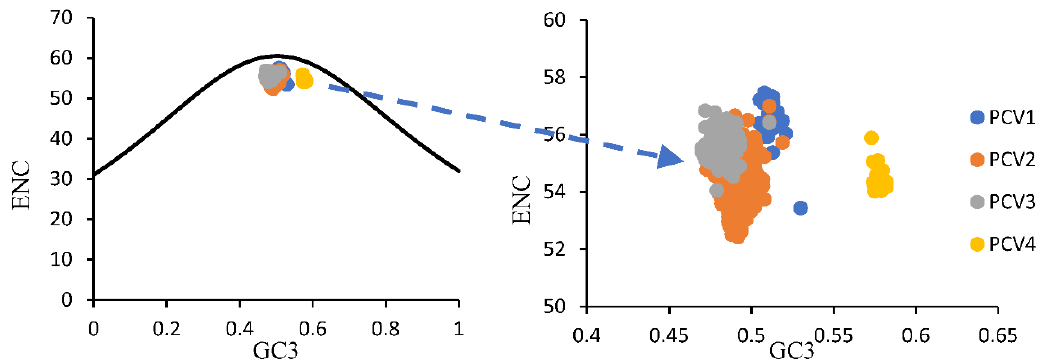
Figure 2. ENC-plot of ORF12s from different PCVs species. PCV-1, PCV-2, PCV-3 and PCV-4 were represented in blue, orange, grey and yellow, respectively. The black curve represented the expected ENC values based on GC3 composition only.